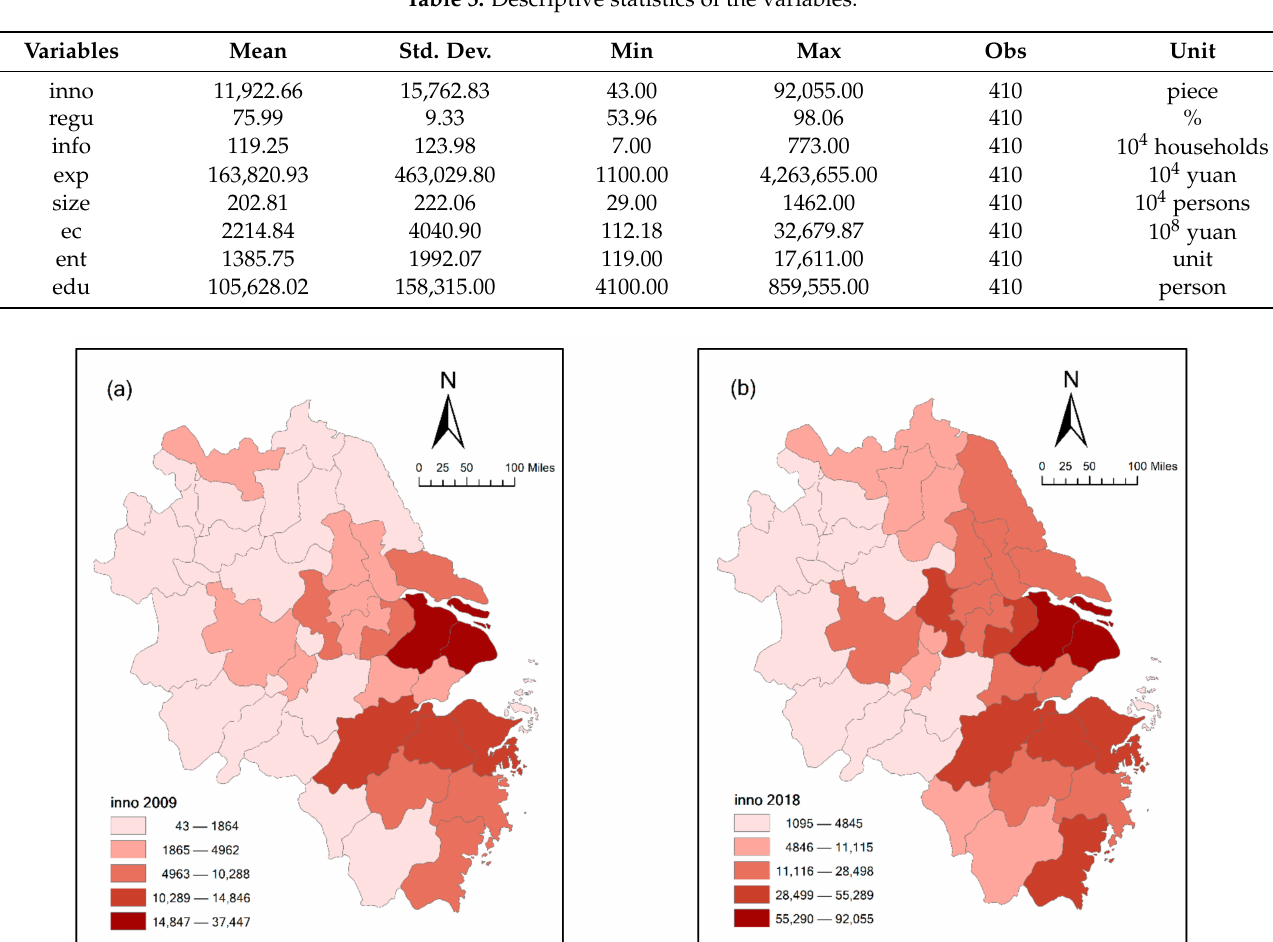
Figure 3. Spatial heterogeneity diagram of urban innovation capacity:( a ) year 2009, ( b ) year 2018.